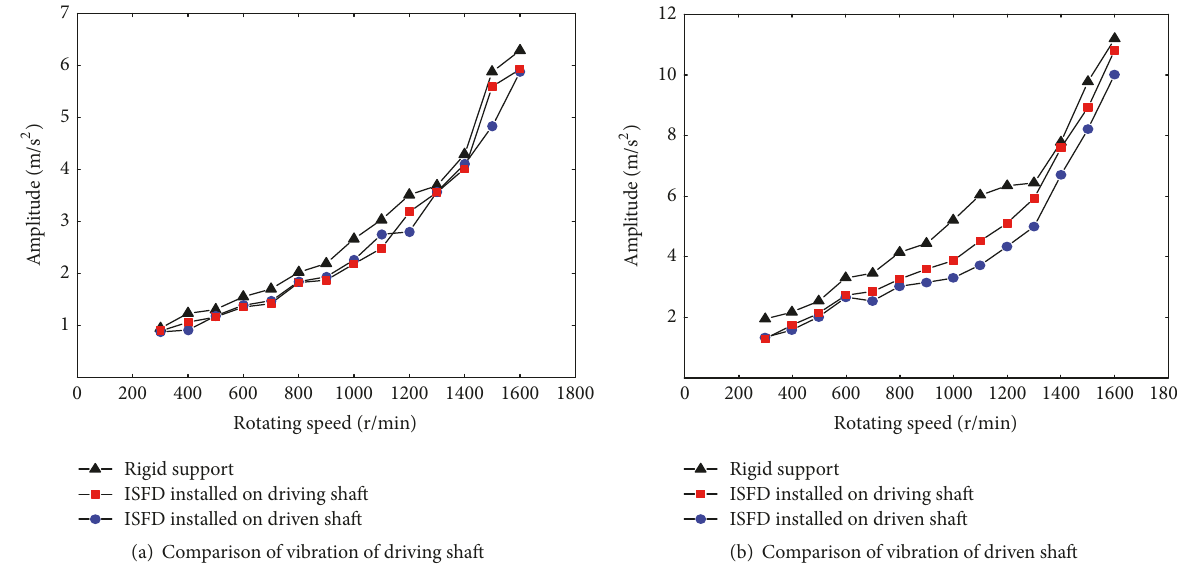
Figure 14: Comparison of vibration under two conditions.